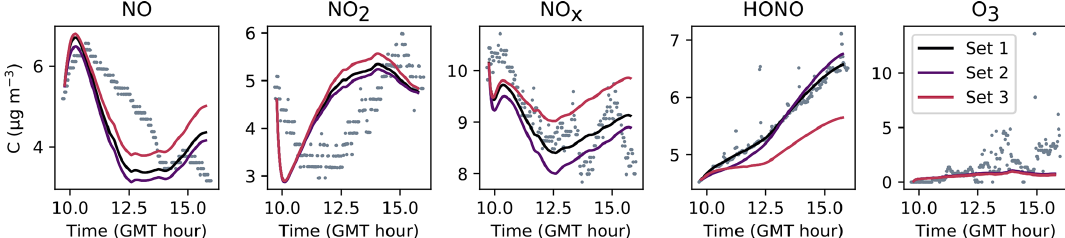
Figure 8. Simulation of Experiment 2 for the three sets of parameters. The dots denote the experimental records. The concentrations simulated in the sunlit box (solid lines) and the concentrations simulated in the shaded box (dashed lines) are superimposed.